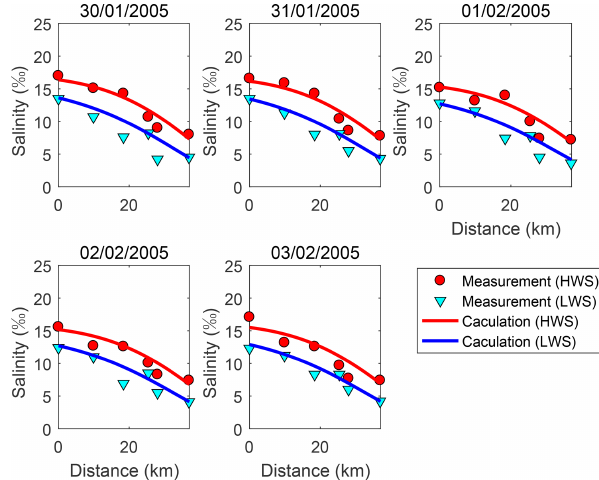
Figure 5. Comparison between validation result and measured salinity concentration along the river from 30 January to 3 Febru- ary 2005.